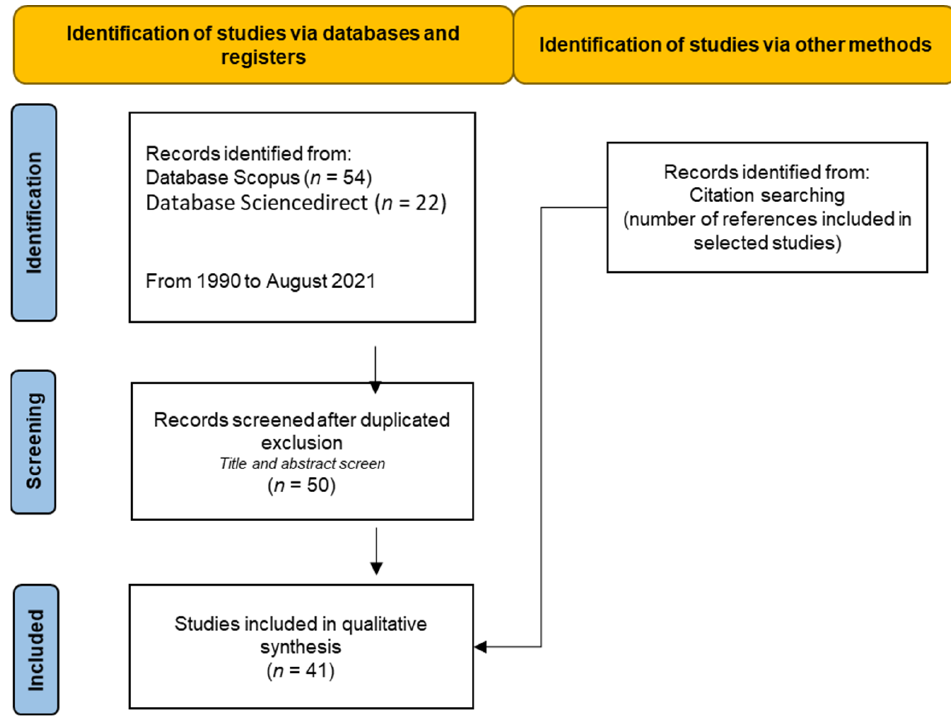
Figure 1. Flow diagram describing the study selection process of the scientific literature.